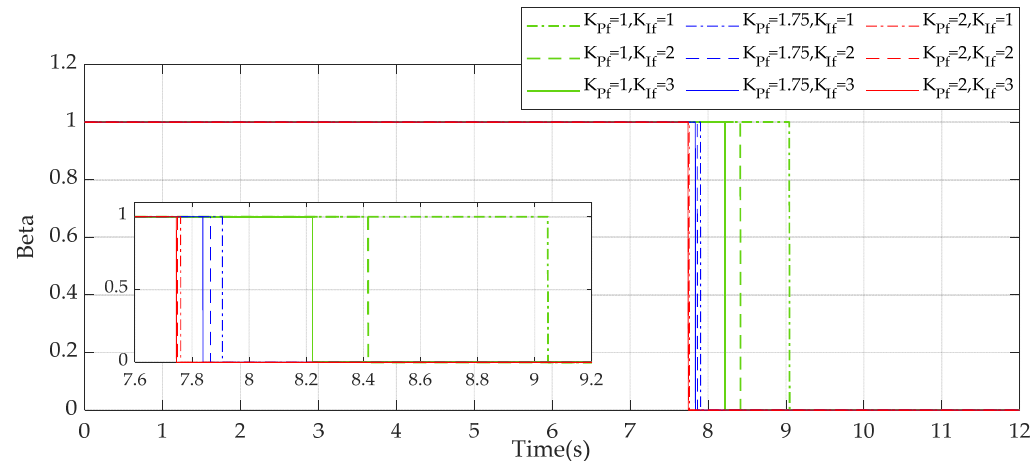
β under di ff erent force control